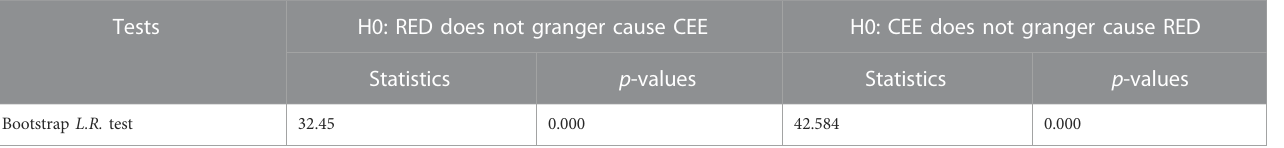
TABLE 11 Bootstrap Granger causality